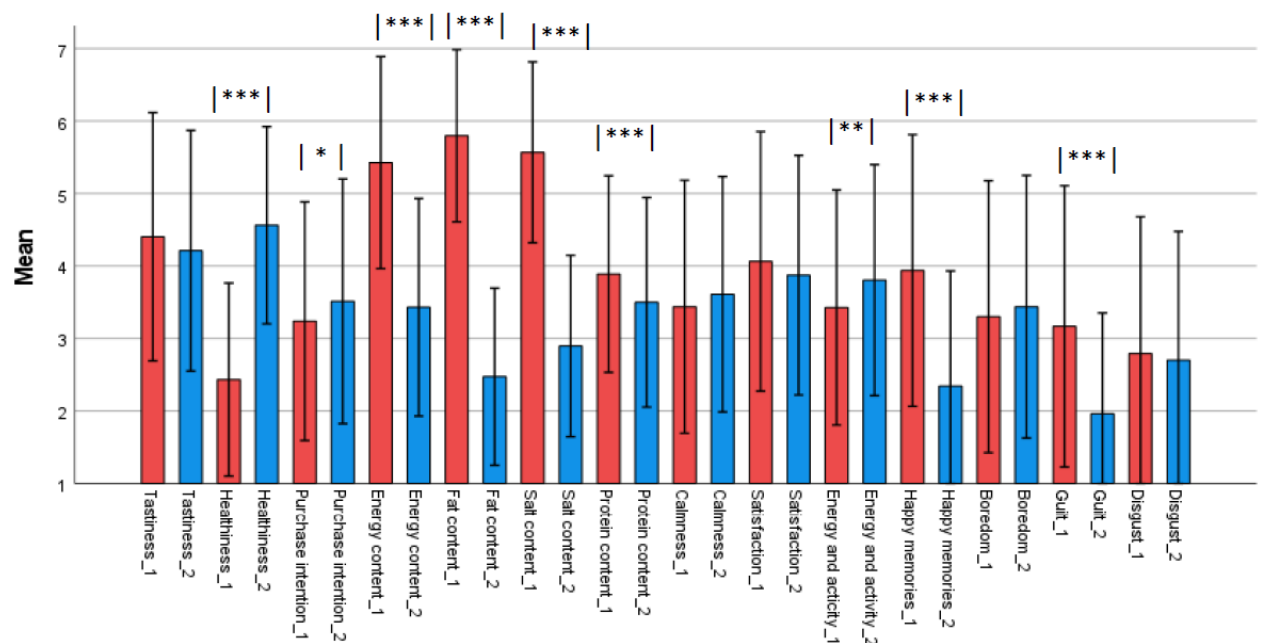
Figure 4. The ratings ( n = 262) of the expected attributes of the products. Product 1 = fried potatoes and sausages (red bars); product 2 = vegetable lentil soup (blue bars). Significant differences (paired- samples t -test) between products 1 and 2 are marked with *** p < 0.001, ** p < 0.01, and * p < 0.05.